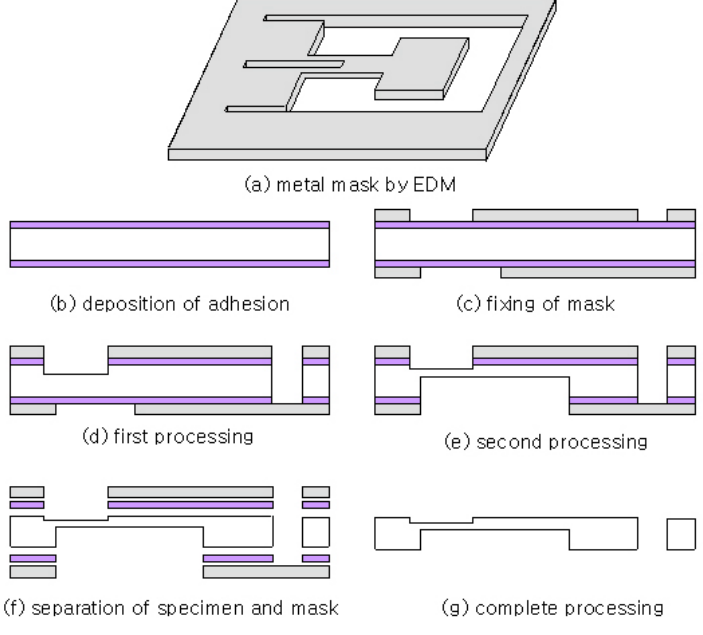
Figure 9. Process flow for the glass-based sensor